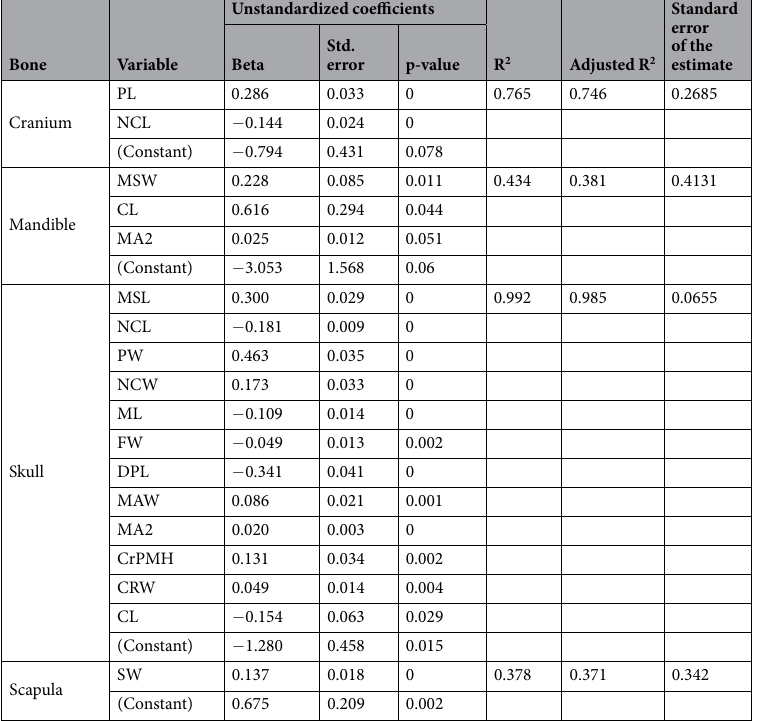
Table 8. The coefficients and coefficients of correlation of linear regression for estimating the body length of dugongs, based on the cranium, mandible, skull and scapula.